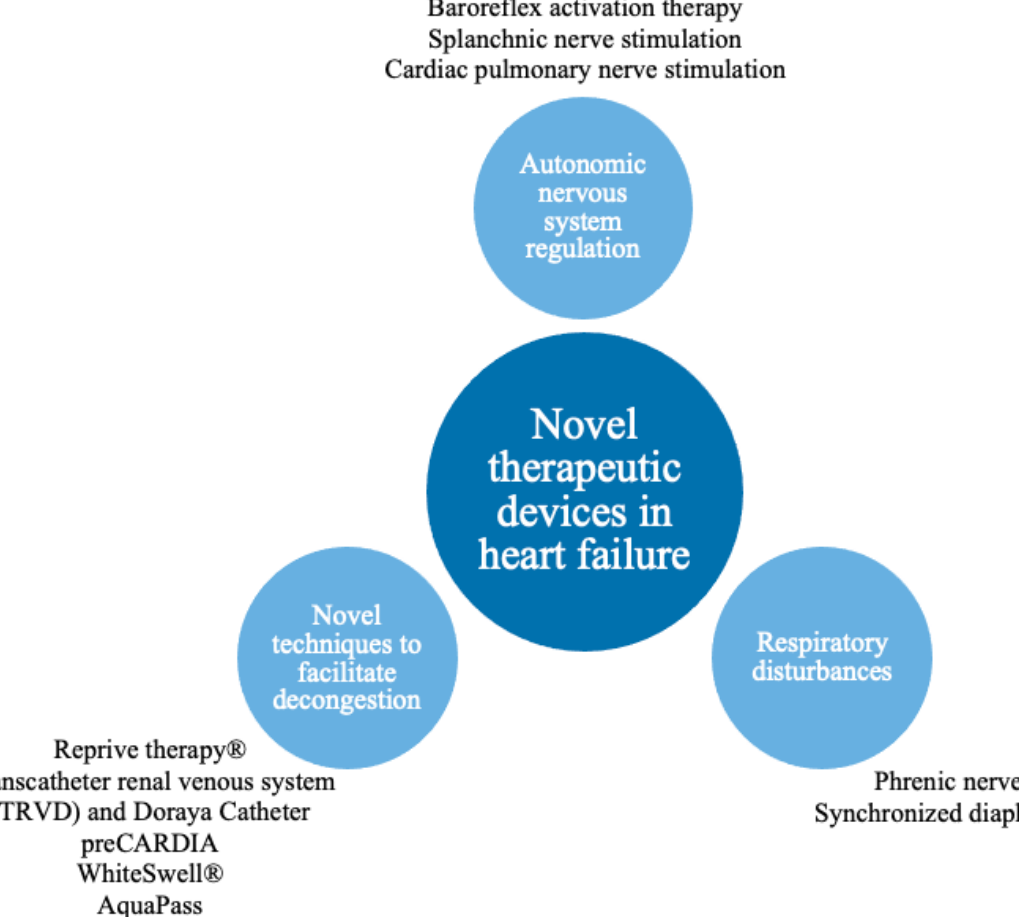
Figure 1. Pathophysiological pathways addressed by novel therapeutic Figure 1 . Pathophysiological pathways addressed by novel therapeutic devices.